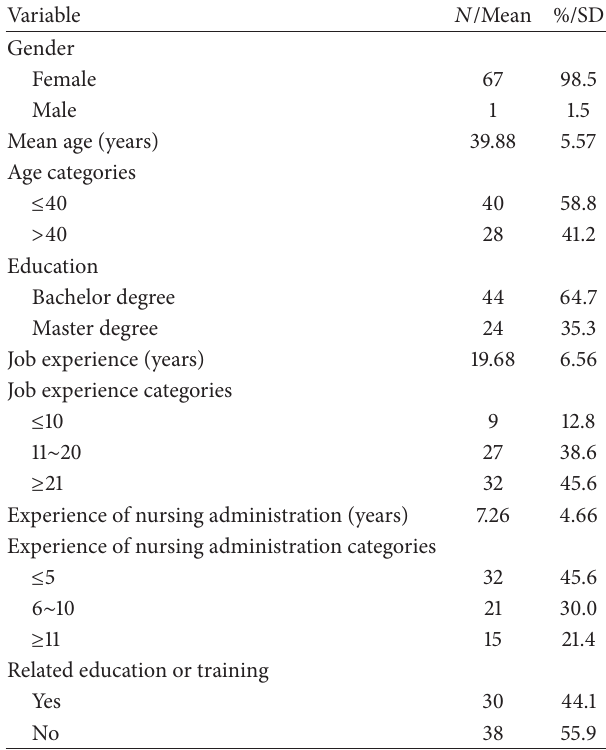
Table 1: Characteristics of research participants ( 𝑁 = 68